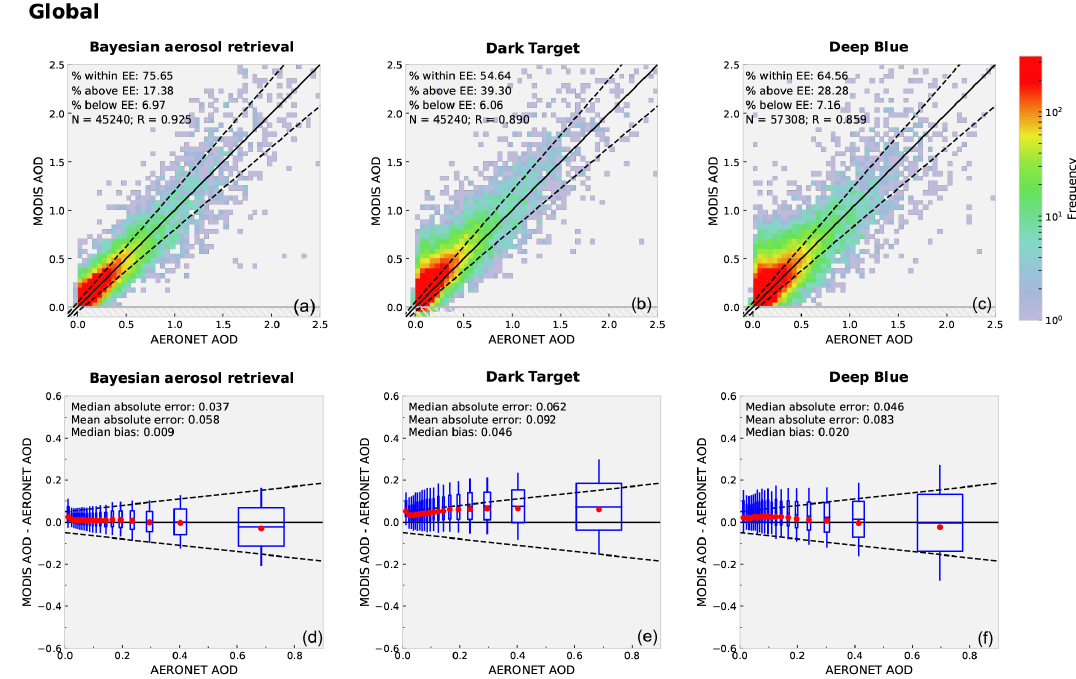
Figure 4. (a, b, c) Scatter density histograms comparing global AERONET and MODIS Bayesian aerosol retrieval (a) , MODIS Dark Target (b) , and MODIS Deep Blue (c) AOD retrievals. The solid black line represents the 1 : 1 line and the dashed lines the MODIS Dark Target expected error envelope. (d, e, f) The retrieval error for MODIS Bayesian aerosol retrieval (d) , MODIS Dark Target (e) , and MODIS Deep Blue (f) retrievals plotted as function of AERONET AOD. The red dots and the horizontal lines inside the boxes represent the median and mean values of MODIS AOD error, respectively. The box height and whiskers represent the 1 and 2 standard deviation intervals of the MODIS AOD retrieval error, respectively. The width of the box corresponds to the standard deviations of the AOD bin. Table 4. Global and regional statistics of AOD retrievals for Dark Target (DT) and Bayesian aerosol retrieval (BAR) retrieval algorithms. All DT quality assurance classes are considered. Bolded numbers indicate the algorithm with better